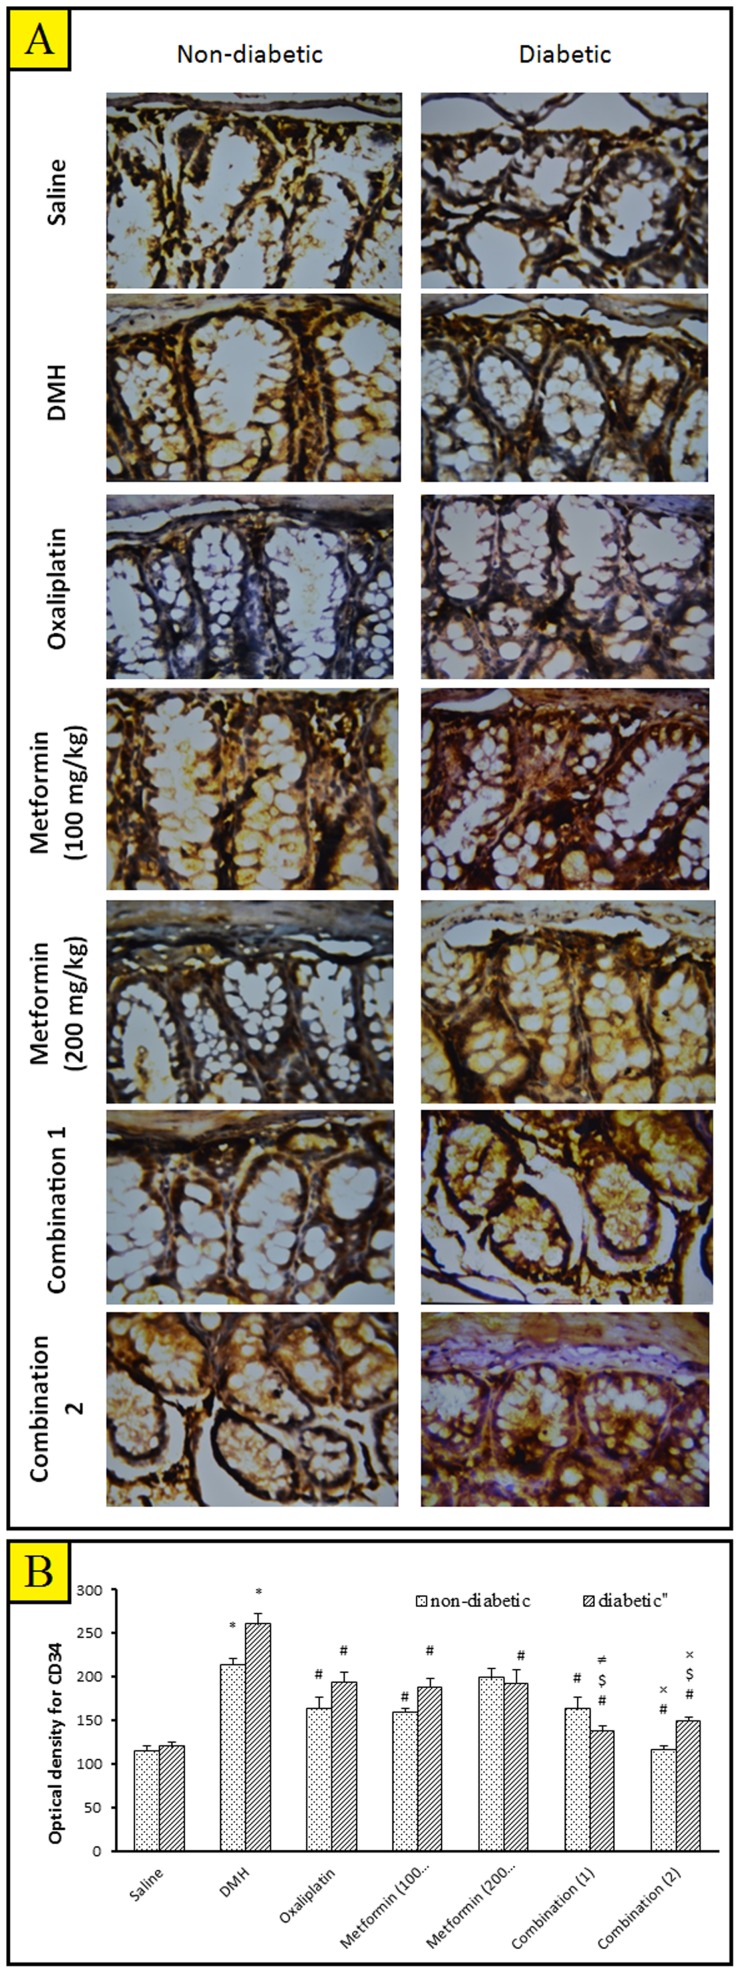
Effect of different pharmacologic treatments on the optical density of CD34 positive cells in the colon tissue.
A) Photomicrographs for colon tissues immunohistochemically stained for CD34 (scale bar  = 238.2 µm). B) A bar chart demonstrating the optical density for CD34 immunostaining in non-diabetic and diabetic mice. Mice [except saline groups] were injected with 1,2-dimethylhydrazine (DMH) weekly for 15 week to induce colon cancer then treated with oxaliplatin and/or metformin (100 or 200 mg/kg) for 4 weeks. Results are expressed as mean ± S.E.M. and analyzed using two-way ANOVA followed by Tukey's post-hoc test at P<0.05.*Significantly different from saline group. #Significantly different from DMH group. $Significantly different from oxaliplatin group. ≠Significantly different from metformin (100 mg/kg) group. ×Significantly different from metformin (200 mg/kg), n = 5–6.